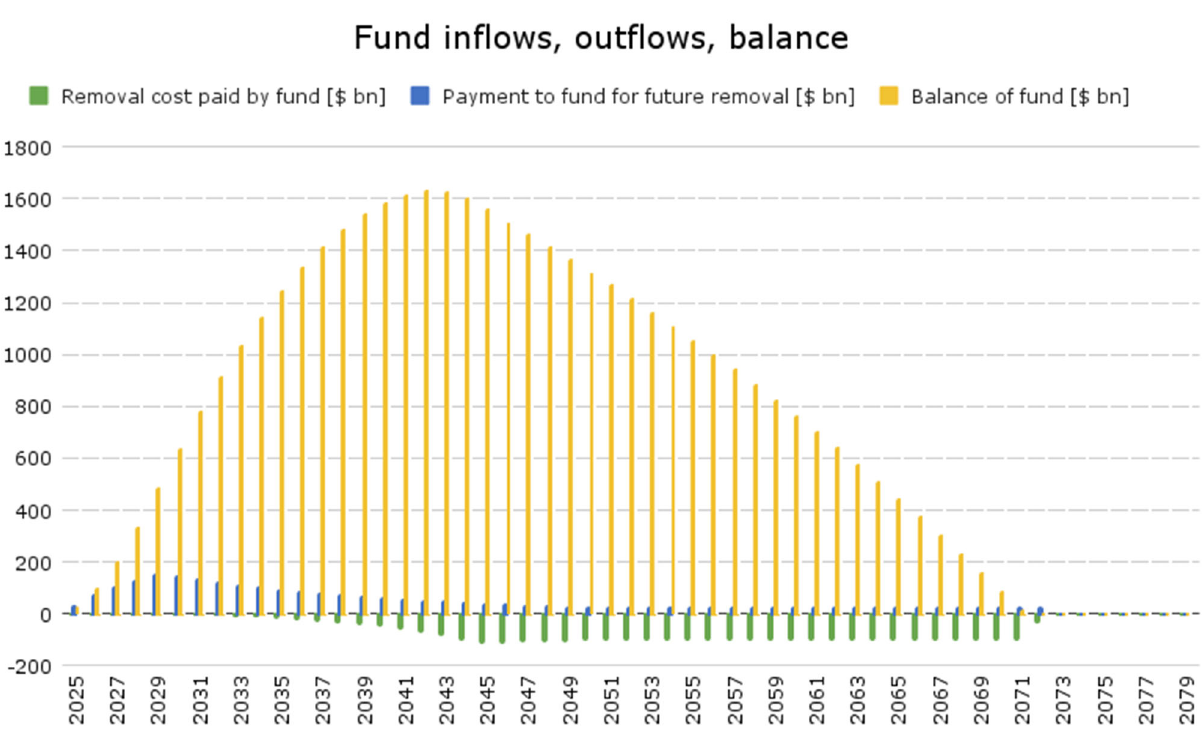
Figure 3. The baseline simulation of financial flows showing differentiated timing of early inflows (high emissions now) and payments for CO 2 removals, which need time to develop.